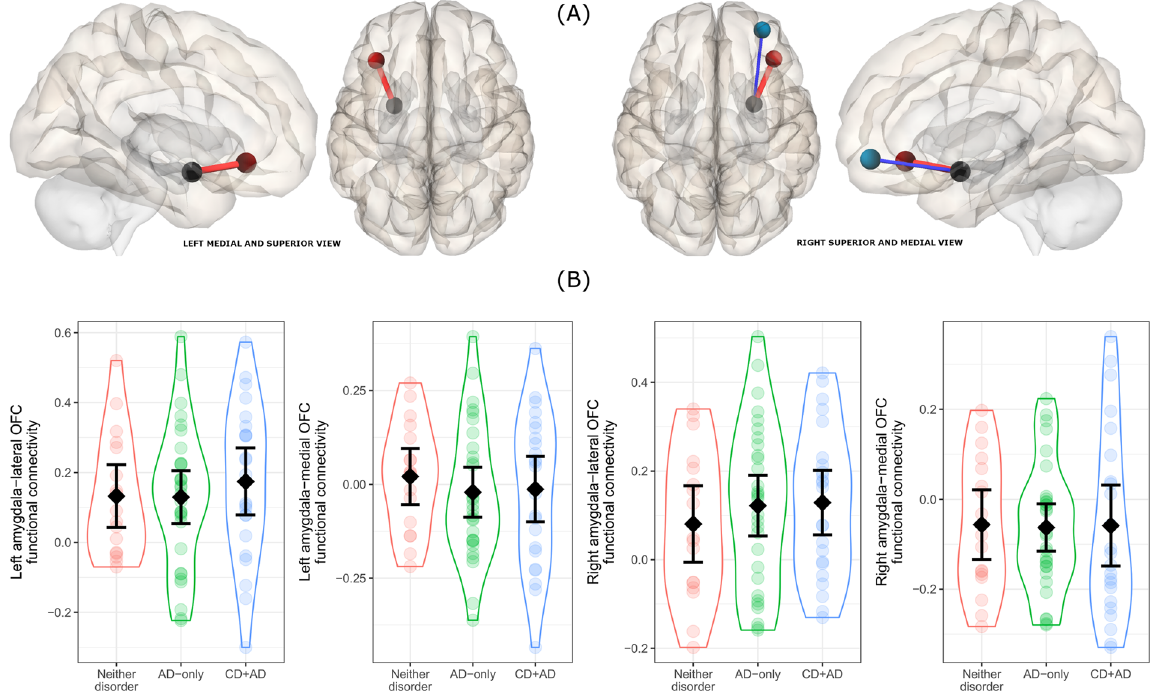
Figure 2. Functional connectivity results. ( A ) Positive (red) and negative (blue) associations between left and right amygdala and antero-medial and lateral OFC targets seeds (non-significant left amygdala-lateral OFC association not shown). ( B ) No significant between-group differences in any functional connectivity measure (group means and 95% confidence intervals superimposed on grouped individual